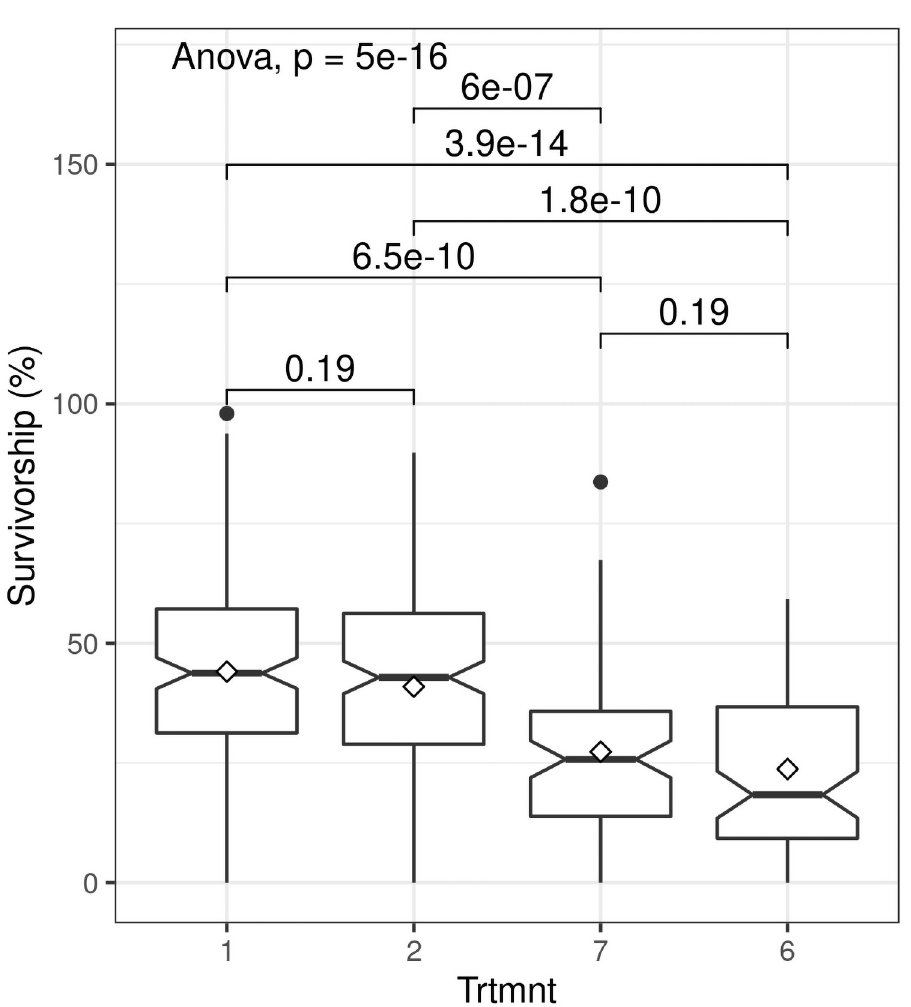
Fig 3. Boxplots showing the effect of stem diameter of planted spekboom ( Portulacaria afra ) truncheons on percentage survivorship for different stem diameters (Trtmnt) (1 = 30 mm, 2 = 22.5 mm, 6 = 15 mm and 7 = 10 mm; see Tables 1 and 2 for details). Within-box horizontal lines depict median values and the diamonds depict mean values. The paired comparisons above the boxes are P values for